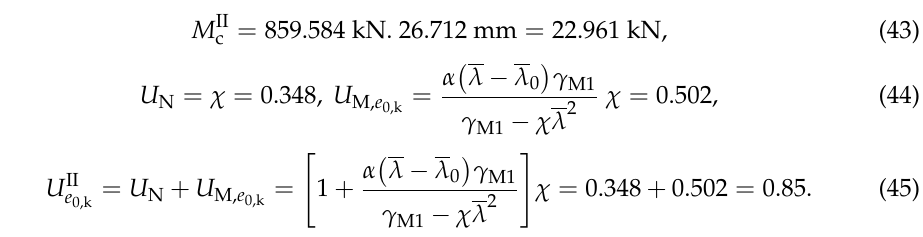
Figure 3. Relevant quantities for 𝛼 = 0.13, 𝛾